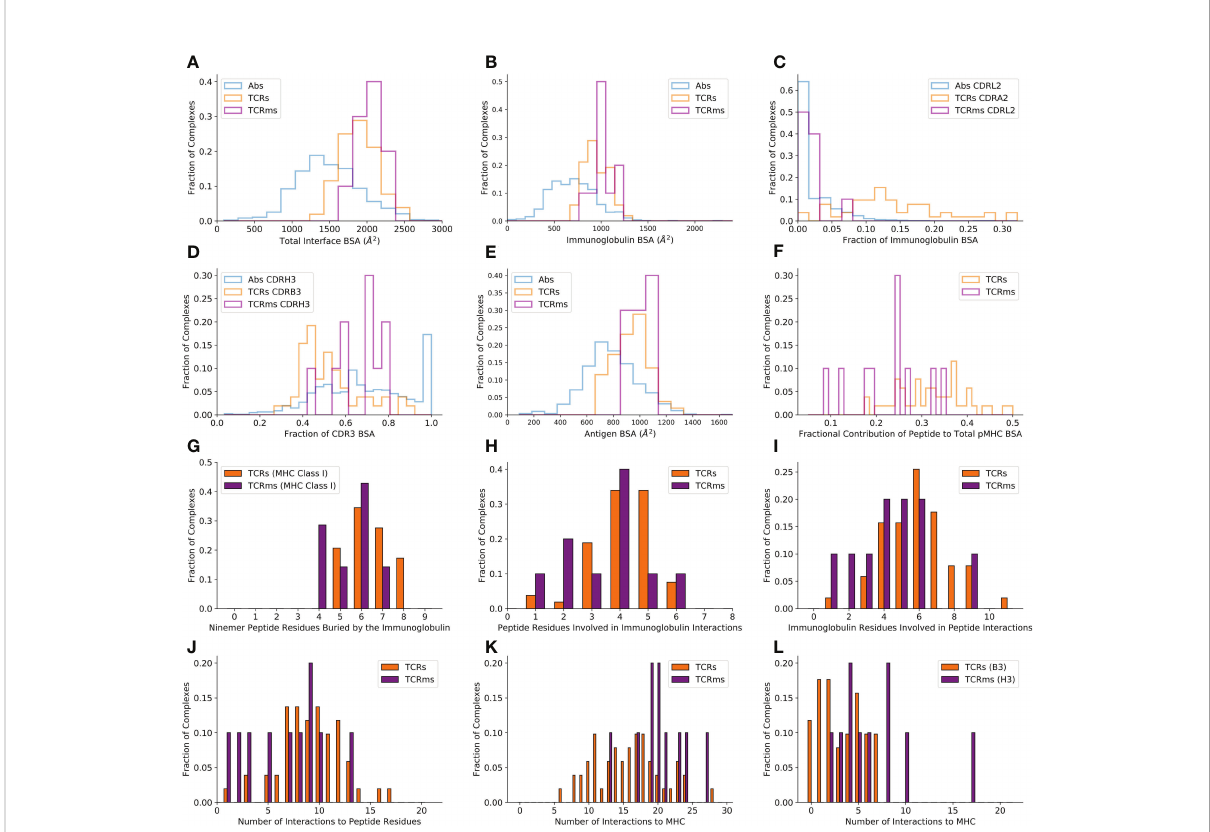
FIGURE 1 Buried surface area (BSA) and interaction pro fi les across the representative complexes from the Structural Antibody Database (6, 7) and Structural T-cell Receptor Database (4). (A) The total BSA across the immunoglobulin:antigen interface. (B) The immunoglobulin portion of the total interface BSA. (C) The fractional contribution of CDRL2 (antibodies, TCRms) or CDRA2 (TCRs) to immunoglobulin BSA. (D) The fractional contribution of CDRH3 (antibodies, TCRms) or CDRB3 (TCRs) to CDR3 BSA. (E) The antigen/pMHC portion of the total interface BSA. (F) The fractional contribution of peptide BSA to pMHC BSA. (G) The number of peptide residues buried in each immunoglobulin to ninemer peptide: MHC Class I complexes. (H) The number of peptide residues involved in binding interactions to the TCRms/TCRs. (I) The number of immunoglobulin residues involved in binding interactions to the peptide across the TCRms/TCRs. (J) The number of interactions between the immunoglobulin and the peptide across the TCRms/TCRs. (K) The number of interactions to MHC residues across the TCRms/TCRs. (L) The number of interactions to MHC residues made by the CDRH3 (TCRms) or CDRB3 (TCRs)